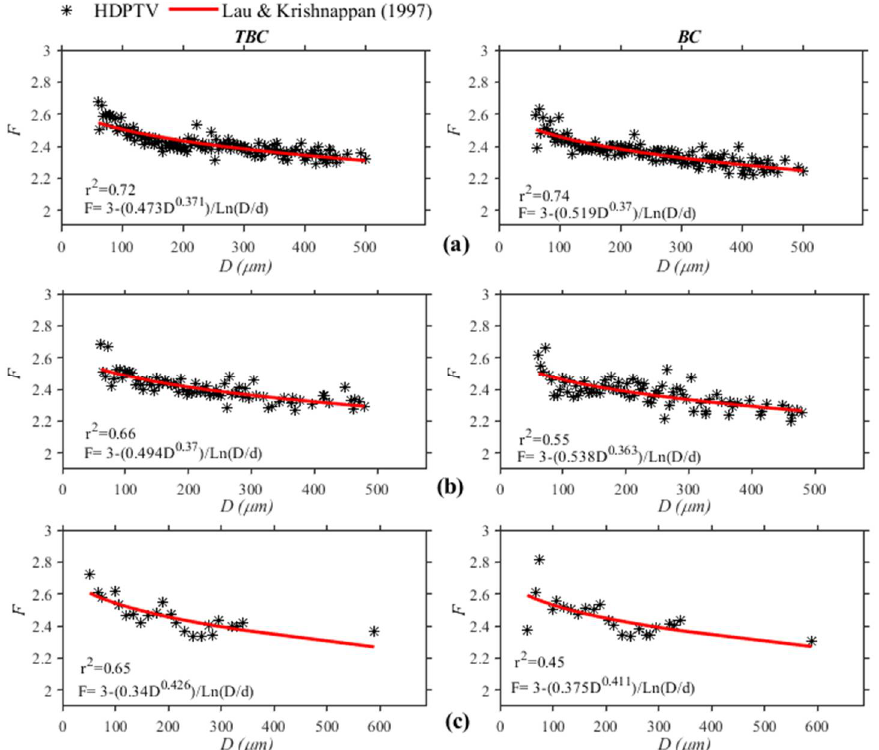
Figure 11. Best fit of the fractal dimension for the Usumacinta River with Lau and Krishnappan [15] model at different flocculation times using TBC and BC methods; ( a ) 30 min, ( b ) 45 min, ( c ) 60 min.